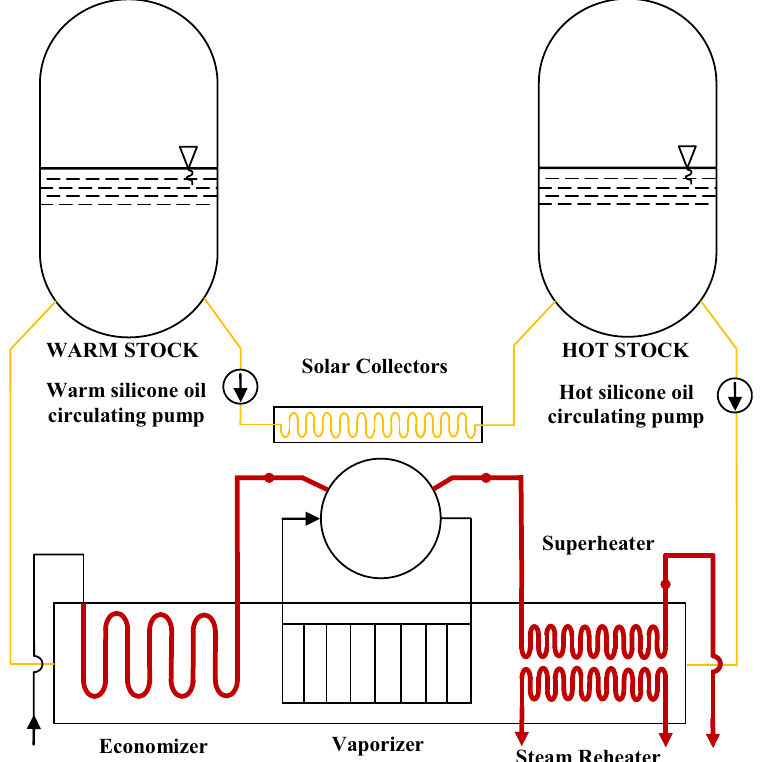
Fig. 1. The diagram of the primary circuit of a CSPP-SC with parabolic trough collectors and thermal storage, including the Steam Generator (SG).